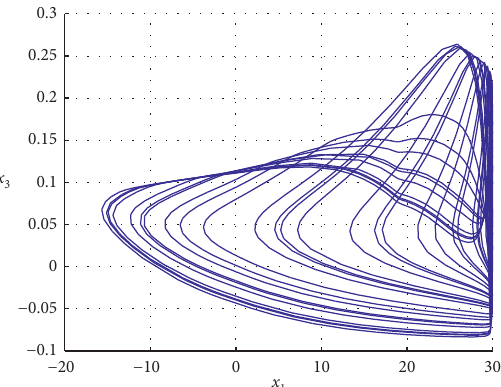
Figure 1: Attractor of chaotic neural network system (1).